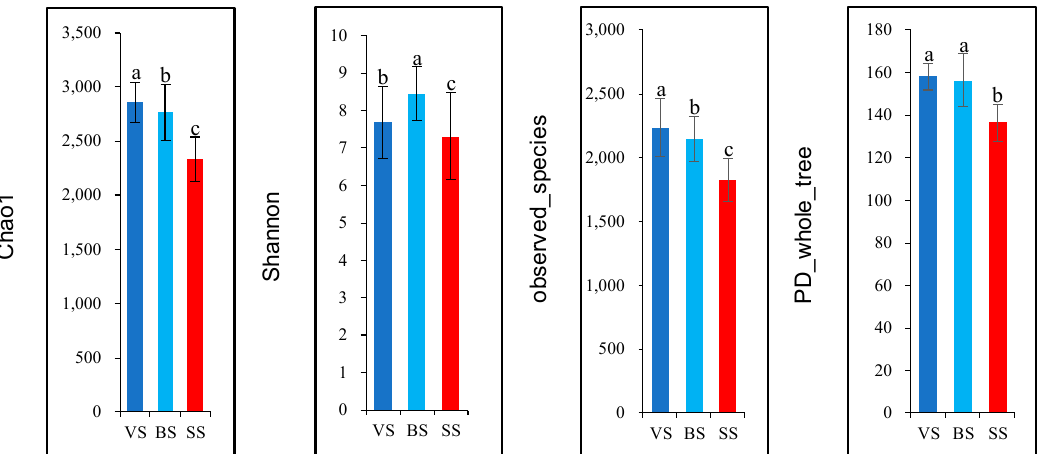
Figure 2. Alpha diversity indices of rumen bacteria in yak cows in different phenological periods. a–c Mean values with different superscripts are different at p < 0.05 according to Duncan’s multiple-range test. VS: Vegetative stage, BS: Bloom stage, SS: Senescent stage.